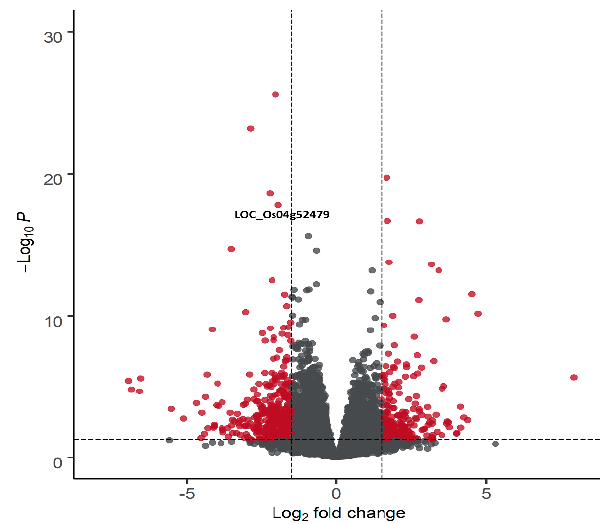
Figure 5. Volcano plot to identify differentially expressed genes in W149 compared with Cypress using DESeq2 R Package. The mean log 2 fold change is plotted against the − log 10 Benjamini–Hochberg-adjusted P-values for all expressed genes. X-axis dotted line represents log 2 fold change threshold ( ≥ 1.5 and ≤− 1.5) while y-axis dotted line is the adjusted p- value cut-off point (<0.05). Red dots represent 330 differentially expressed genes. Gray dots represent genes that did not pass the filtering criteria. Plot was visualized using R package “EnhancedVolcano.”